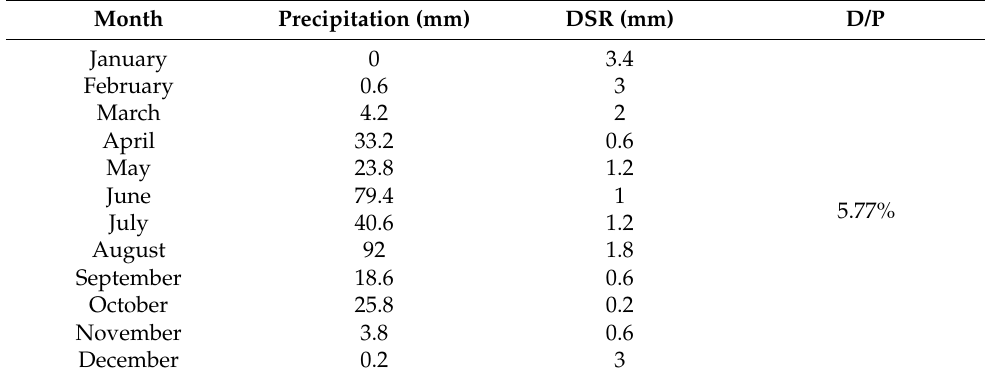
Table 1. Monthly cumulative precipitation—DSR amount in every month from 2016 to 2020 .